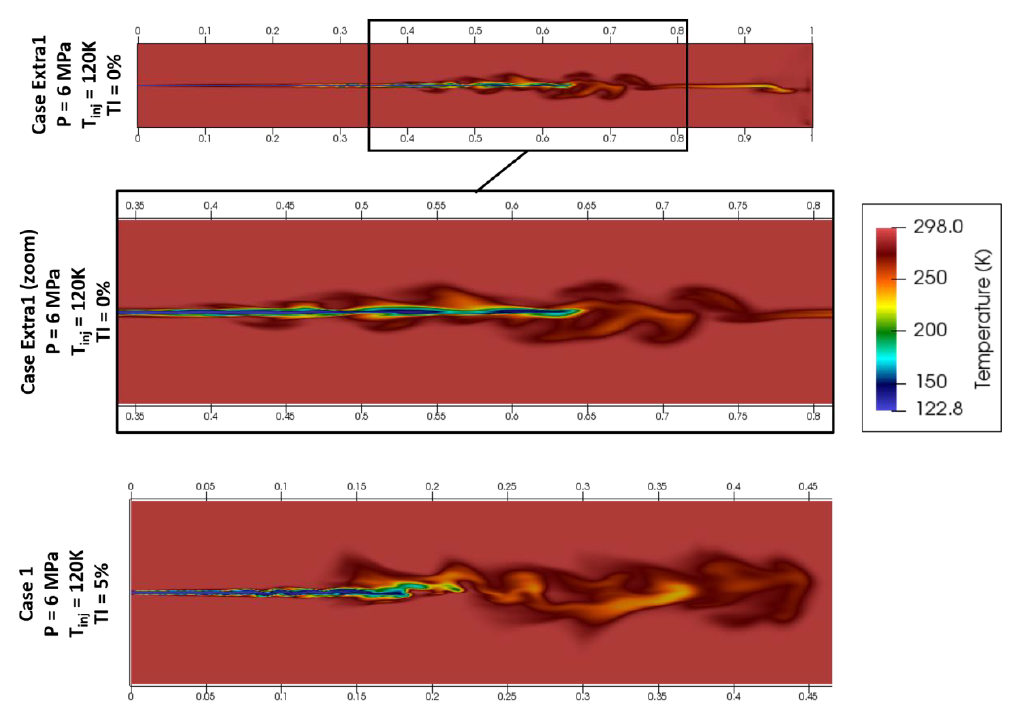
Figure 18. Temperature distribution comparison at cut section plane passing through the axis of the cylindrical mesh (chamber) for case 1 with and without turbulent fluctuations at the